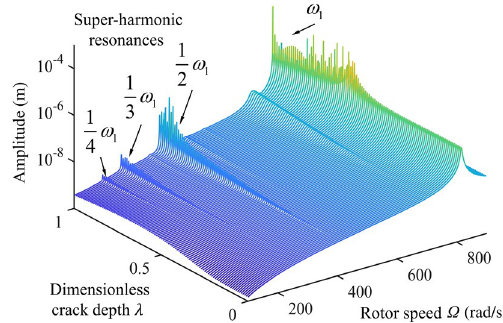
Figure 4 3D waterfall diagram of rotor speed-dimensionless crack depth-amplitude at node 10 ( c p